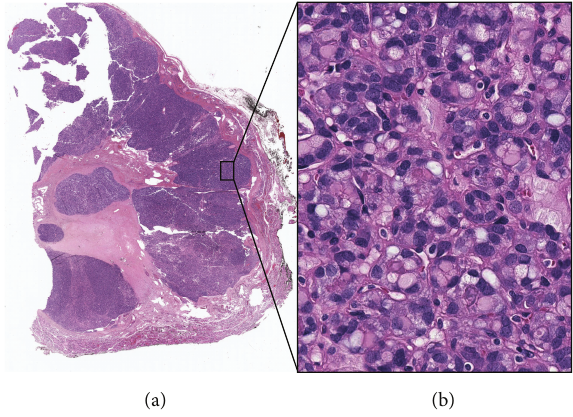
Figure 3: Representative images of a follicular neoplasm of uncer- tain malignant potential previously treated with RFA. (a) The lower magnification (0.6x) picture shows central scattered areas of hyaline sclerosis and scarring due to RFA, which do not affect the capsule. (b) The higher magnification (40x) picture shows signet ring cells, random nuclear atypia, and clearing cell